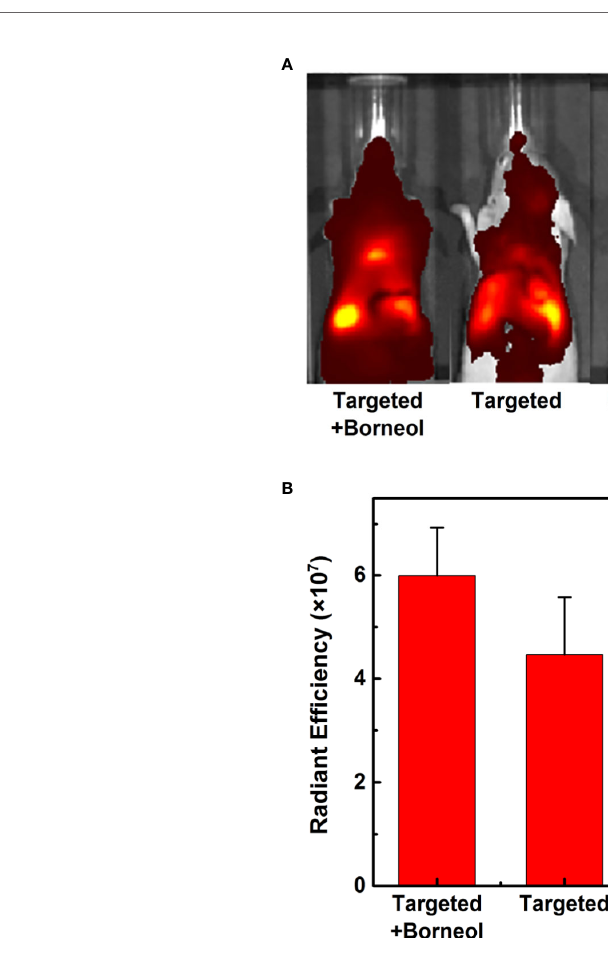
FIGURE 8 | In vivo fl uorescence imaging of U87MG glioma-bearing nude mice after administration with DiR-labeled CGKRK-PSNPs with borneol, DiR-labeled CGKRK-PSNPs, DiR-labeled PEG-PSNPs with borneol, and DiR-labeled PEG-PSNPs (A) . The corresponding semi-quantitative radiant ef fi ciency of brains (B) . * P < 0.05 signi fi cantly lower than that of CGKRK-PSNPs with borneol.